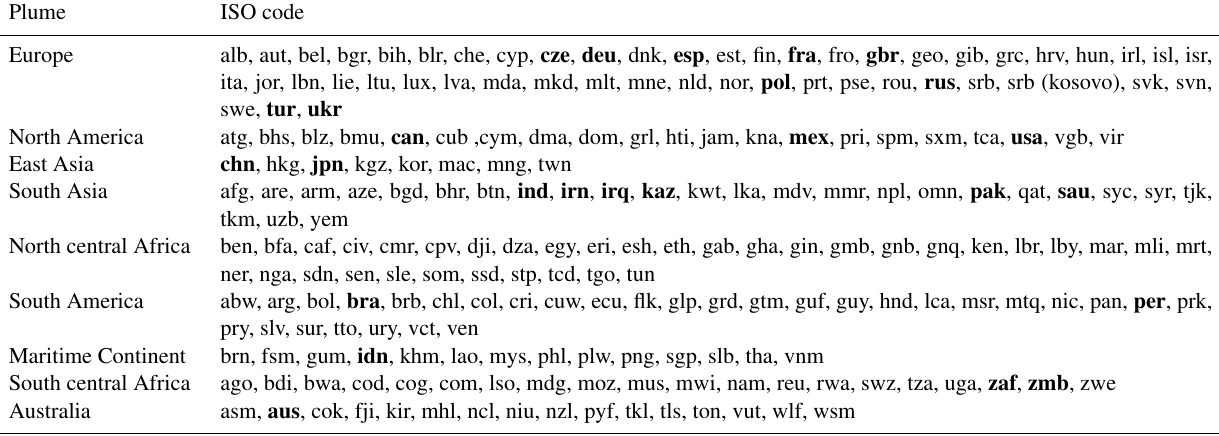
Table 4. ISO codes for countries contributing to individual plumes. The union codes of the set of 20 countries with the largest amount of 2014 SO 2 emissions and the set of the 20 countries with the largest total SO 2 emissions since 1850 are indicated in bold. Plume